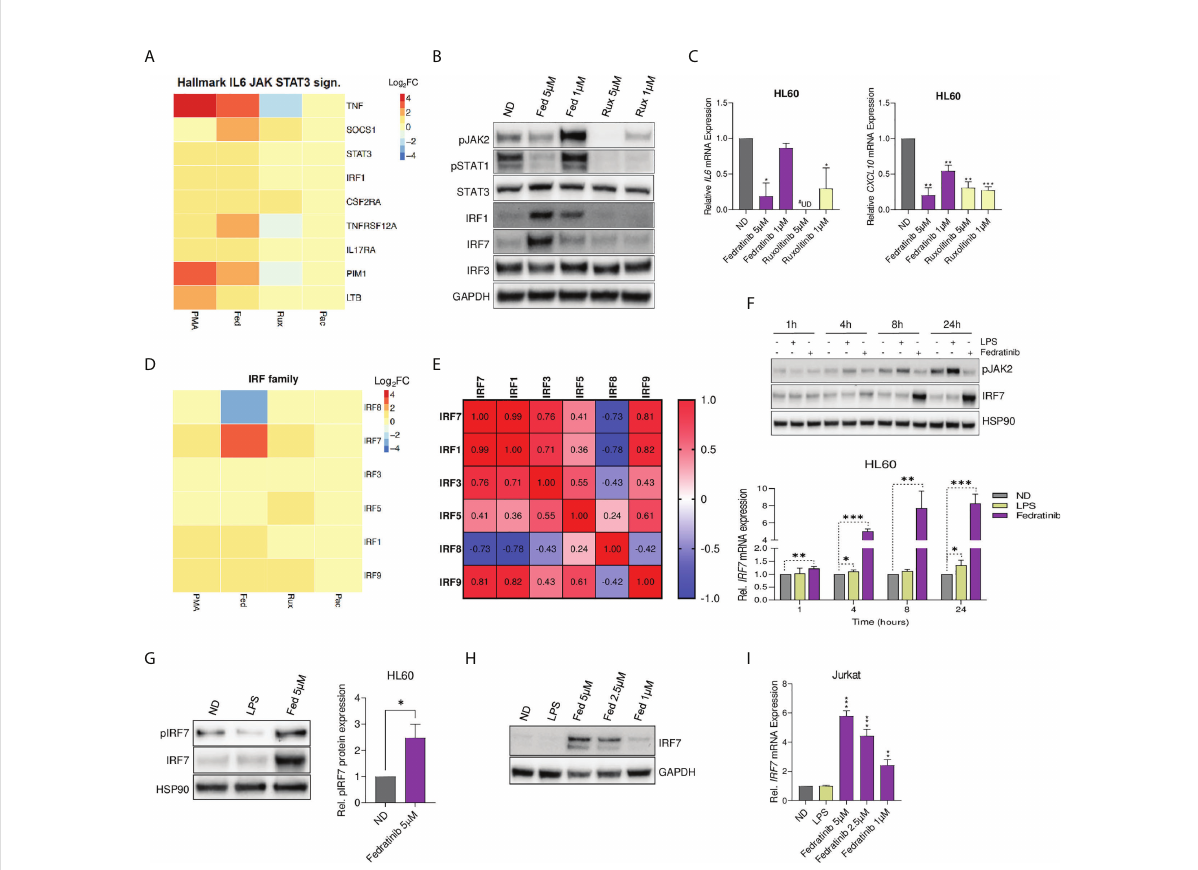
FIGURE 4 Fedratinib upregulates IRF7 expression despite blockade of JAK-STAT signalling and cytokine production. (A) Gene expression of leading-edge genes from the Hallmark IL6-JAK-STAT3 signalling gene set. Fedratinib treatment condition was used as a reference set for leading-edge genes selection and ranking. (B) Evaluation of JAK-STAT signalling pathway at protein level in JAKi-treated HL60 cells using western blot analysis. GAPDH was used as a loading control. (C) Gene expression of IL6 and CXCL10 following treatment with JAKi. Relative mRNA expression was measured by quantitative RT-PCR and normalized to GAPDH. (D) Heatmap showing all differentially expressed interferon regulatory factors (IRF) from whole transcriptome analysis. (E) Spearman correlation matrix for differentially expressed IRF. Negatively and positively correlated gene expression of IRF in the transcriptomic data are shown in blue and red, respectively. (F) Western blot analysis showing time dependence of IRF7 induction by fedratinib despite consistent blockade of JAK2 phosphorylation. LPS treatment was used as a positive control for the activation of the JAK-STAT pathway (induction of pJAK2), and HSP90 as a loading control. Induction of IRF7 gene expression was con fi rmed by qRT-PCR. (G) IRF7 activation measured by protein expression of phosphorylated IRF7 (pIRF7) in HL60 cells treated with either fedratinib or LPS for 24 h A representative experiment is shown. Bar plots represent the mean quanti fi cation of pIRF7 bands obtained by densitometry analysis of three independent experiments. Values were normalized to that of Hsp90 used as a loading control and relativized to the untreated condition (ND). (H, I) Dose-response induction of IRF7 expression upon 24 h fedratinib treatment in Jurkat cells by Western blot analysis (H) and qRT-PCR (I) . Data are expressed as mean ± SEM of at least three independent experiments. ∗ p<0.05; ∗∗ p<0.01; ∗∗∗ p<0.001. # UD - undetermined cycle threshold (below limit of